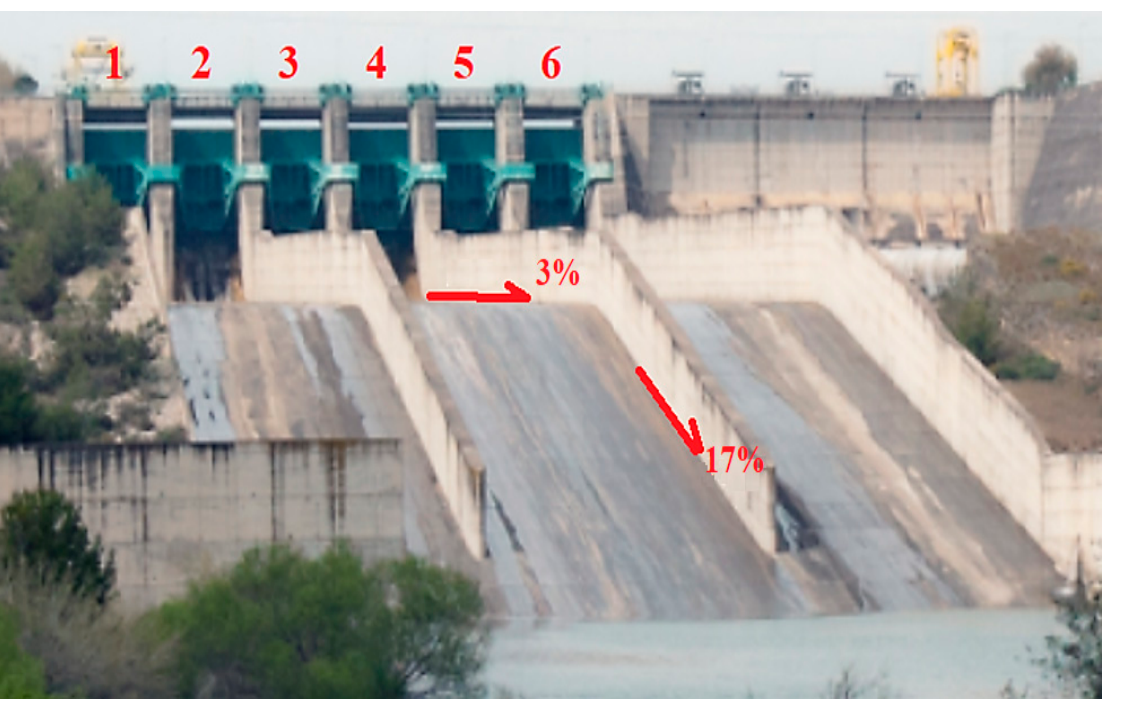
Figure 1. Çatalan Dam spillway structure. 1–6 numbers indicate chambers and arrows indicate 3% and 17% slopes in the discharge channel.